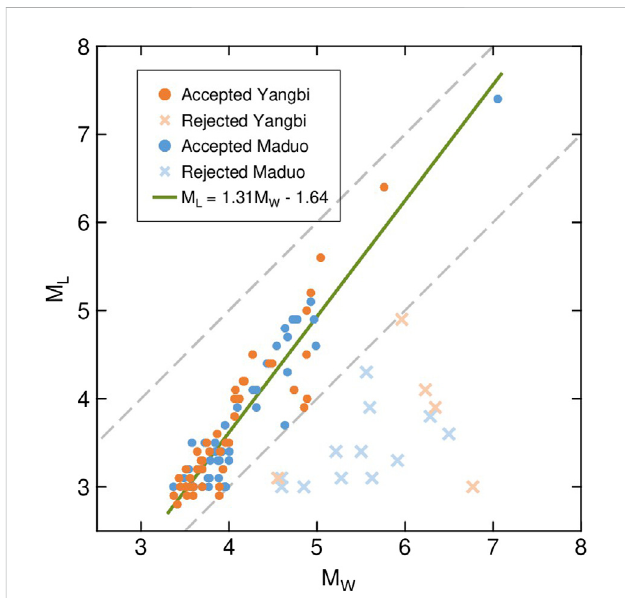
FIGURE 5 Comparison between the retrieved moment magnitude and catalog magnitude. Two gray dashed lines represent M L − M W (cid:2) ± 1 . 0, which are used to screen the retrieved source spectra with unusually large uncertainties (Goertz-Allmann et al.,